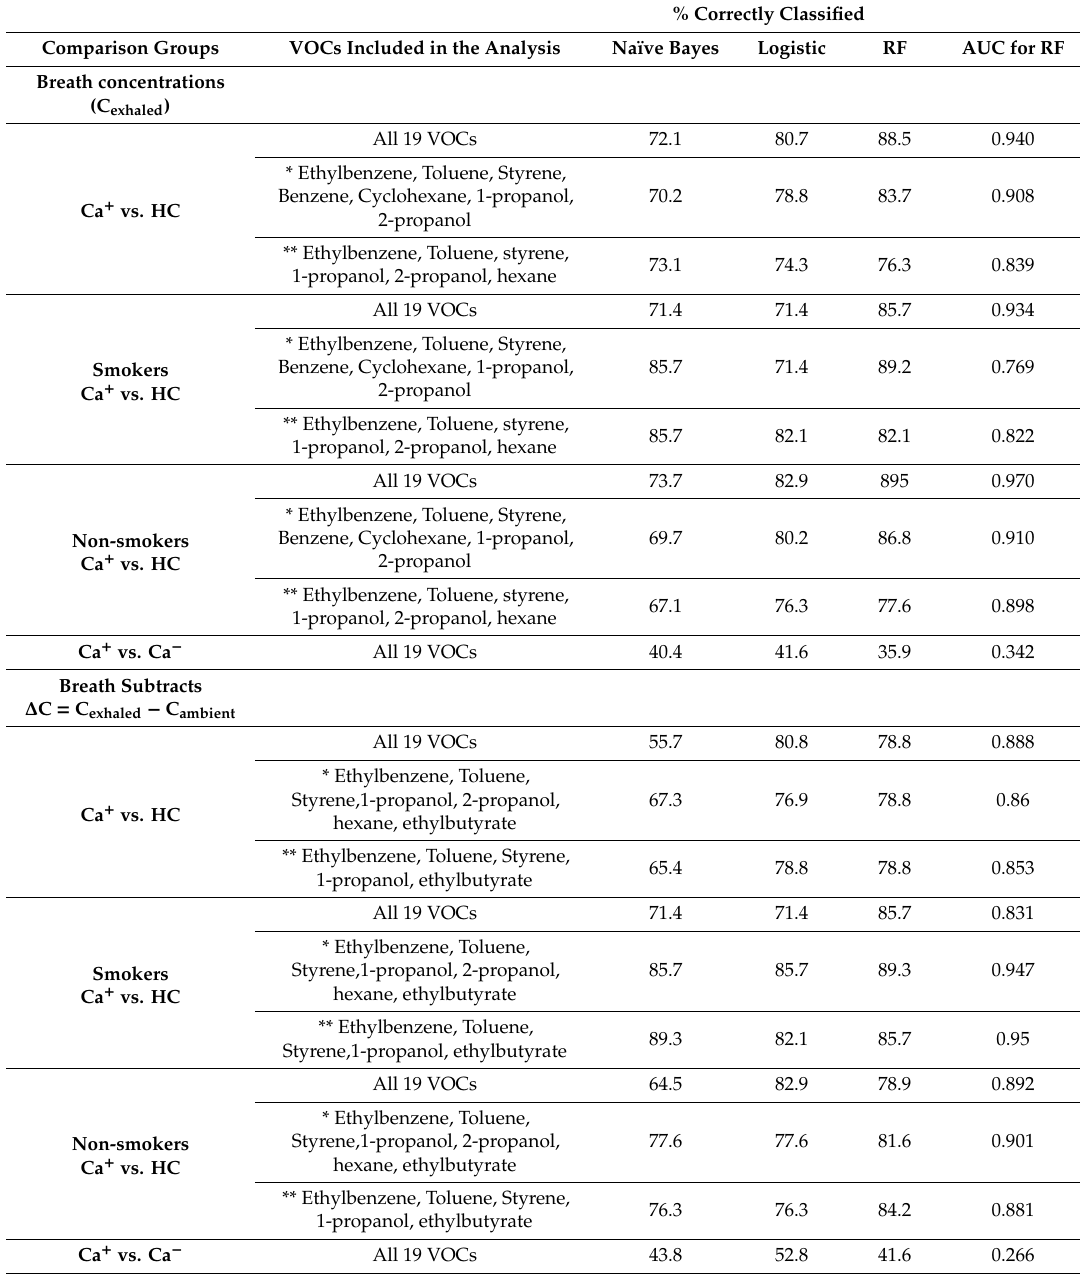
Table 5. Summary of correct classification, based on naïve Bayes, logistic regression, and random forest machine learning